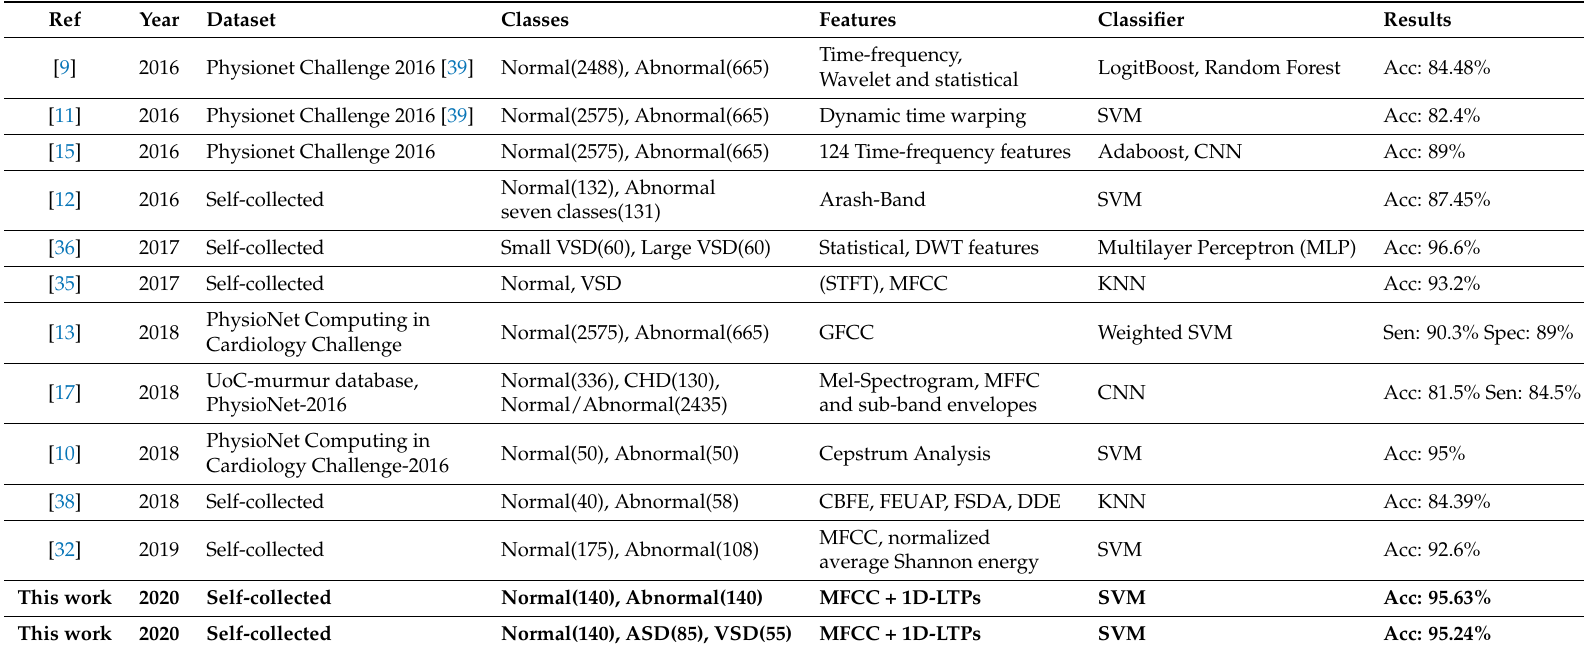
Table 1. Comparison with existing